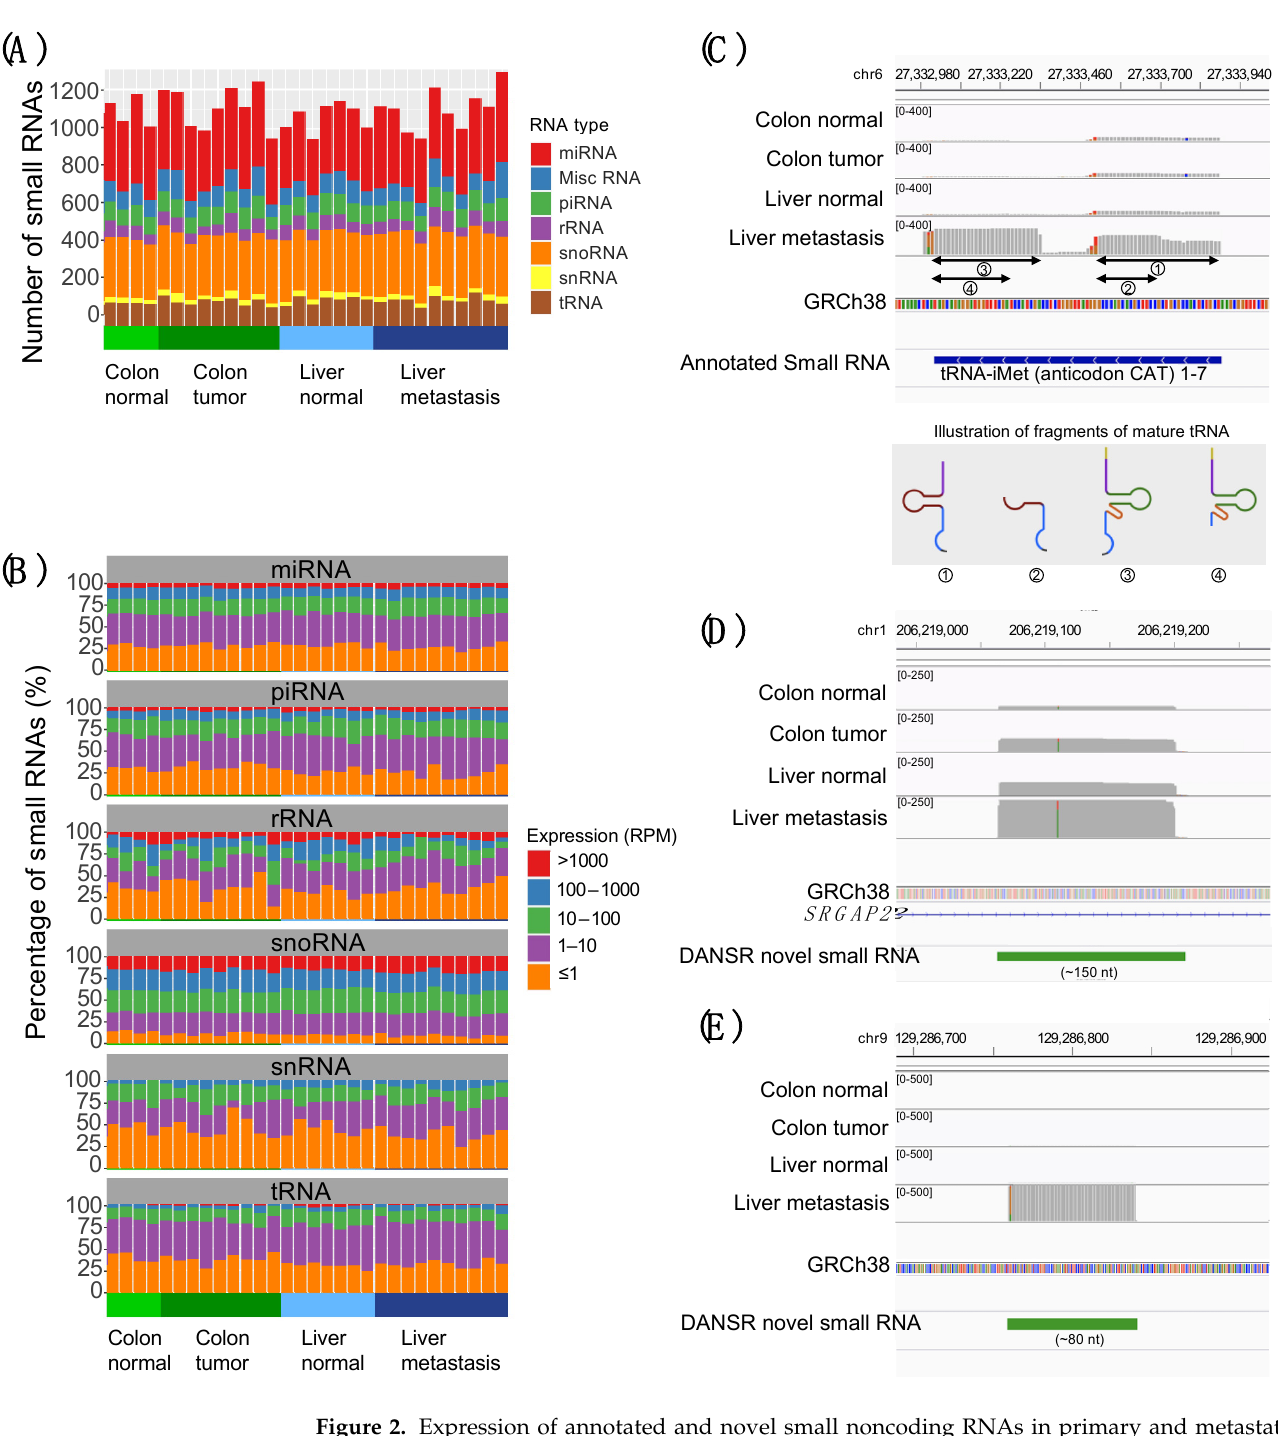
Figure 2. Expression of annotated and novel small noncoding RNAs in primary and metastatic colorectal cancer samples. ( A ) Number of annotated small RNAs identified in matched colon and liver samples for multiple small RNA species. ( B ) Expression of annotated small RNAs in matched colon and liver samples. ( C ) An example of tRNA expression (tRNA-iMet (anticodon CAT) 1–7). This previously annotated tRNA is shown to be supported by reads of different lengths that cover multiple fragments of the mature tRNA. ( D ) Example of a previously unannotated small noncoding RNA discovered by DANSR. This small RNA is intronic of SRGAP2, ~150 nt in length. ( E ) Example of another previously unannotated small noncoding RNA discovered by DANSR, which is intergenic and ~80 nt in length. The full list of previously annotated and unannotated small noncoding RNAs from the colorectal cohort is included in Table S3.